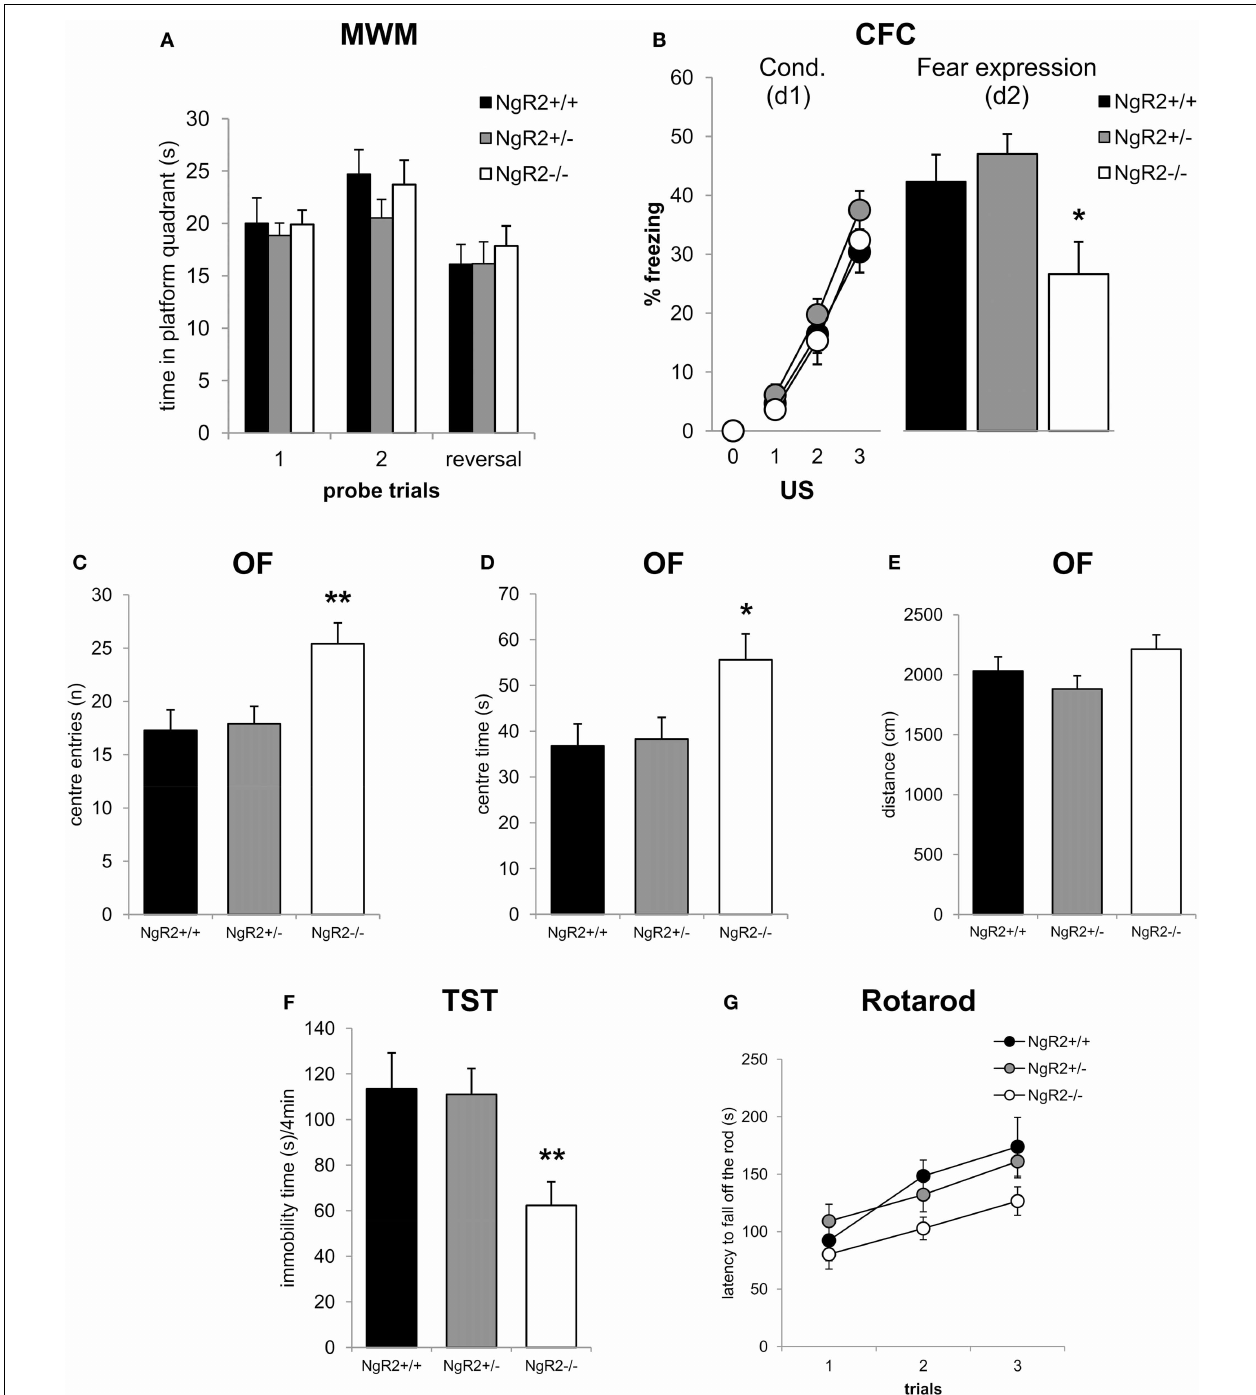
FIGURE 3 | Altered emotionality in NgR2 − / − mice. (A) In the Morris water maze NgR2 + / + , NgR2 + / − , and NgR2 − / − did not differ in the time spent in the platform quadrant of the maze during 2 probe trials and a reversal trial. (B) Contextual fear conditioning. NgR2 + / + , NgR2 + / − , and NgR2 − / − mice show similar acquisition of the task, measured by increased freezing behavior over 3 presentations of the unconditioned stimulus (US) in the context. On d2, exposure to the context alone elicited reduced freezing behavior in NgR2 − / − compared to NgR2 + / + and NgR2 + / + . (C–E) In the open field,